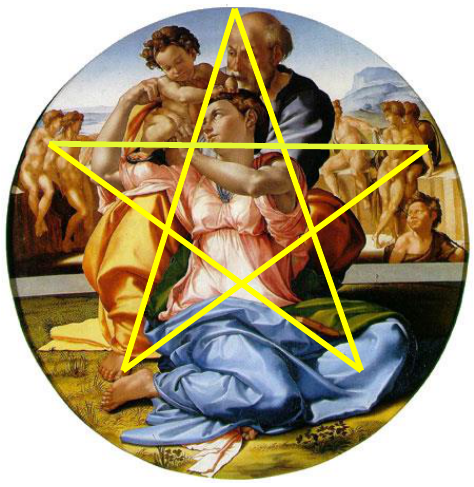
Fig. 7 The Holy Family (Michelangelo, 1506-1508) 3. PERSPECTIVE AND PROJECTIVE GEOMETRY